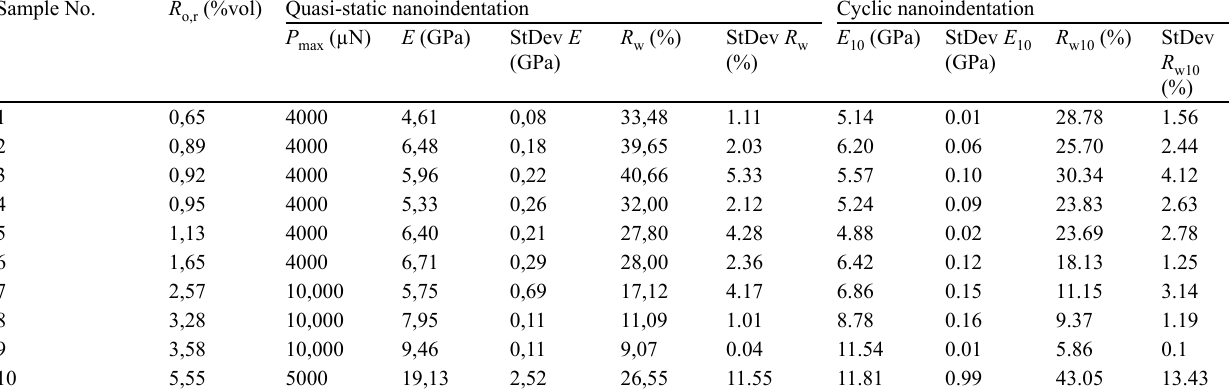
Table 4 Results of coals mechanical properties measurements at microscale Sample No.